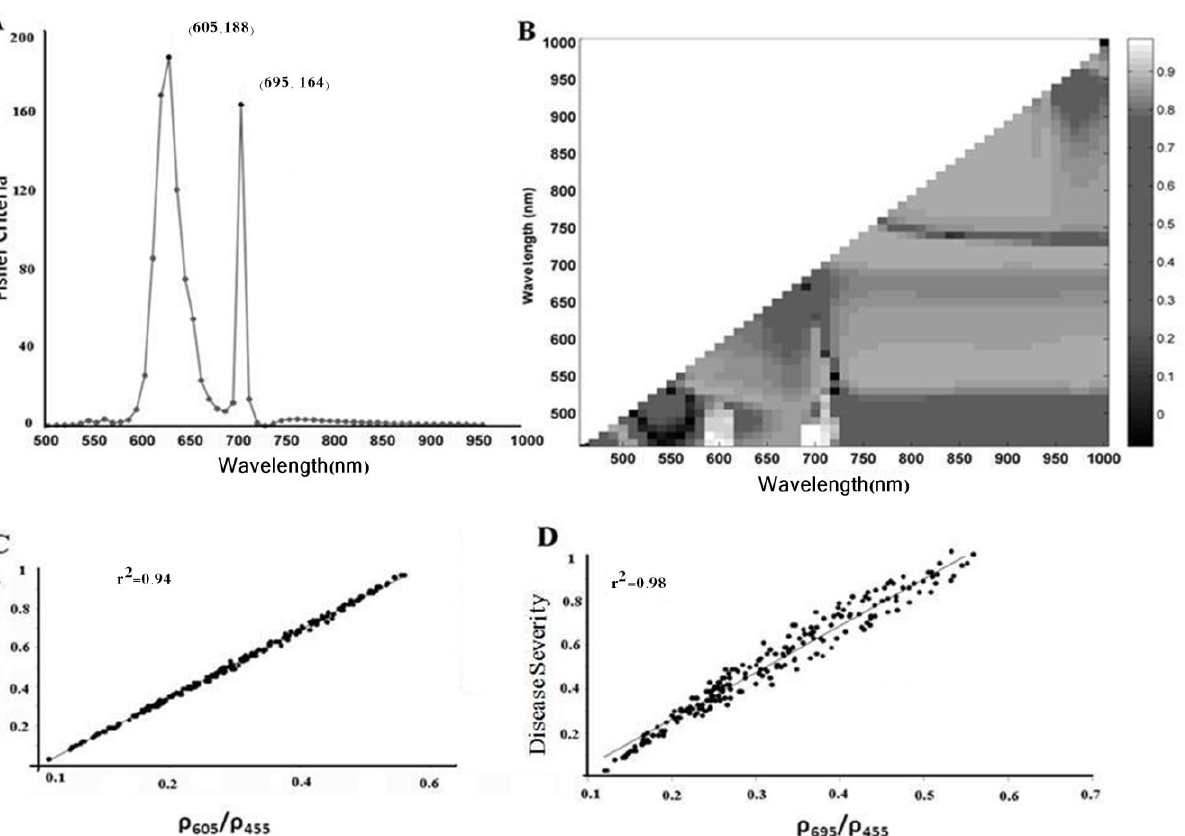
Figure 5. ( A ) Values of the Fisher function at various wavelengths used for disease severity estimation; ( B ) R 2 values between the reflectance ratio of two wavelengths and the leaf disease severity; ( C ) The correlation between the disease severity and ratio of reflectance at 605 nm and 455 nm; ( D ) The correlation between the disease severity and ratio of reflectance at 695 nm and 455 nm